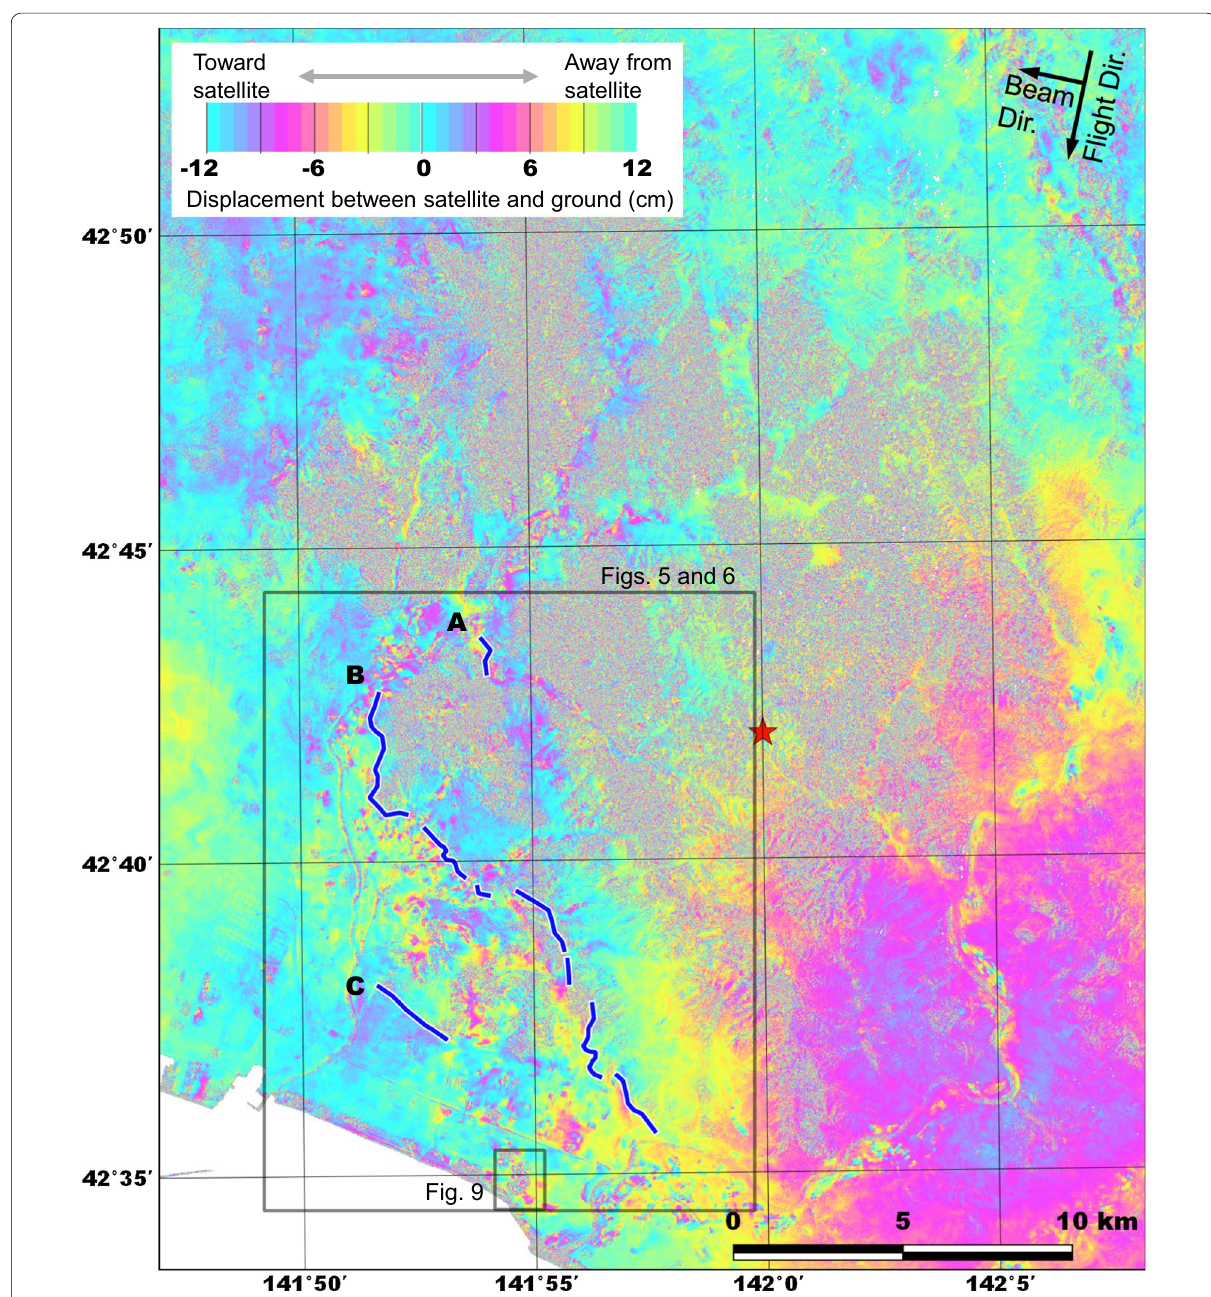
Fig. 2 ALOS-2 SAR interferogram of image pair 3 (Table 1) showing the linear surface displacements identified in this study. The red star shows the epicenter of the 2018 Hokkaido Eastern Iburi Earthquake (Earthquake Research Committee 2018). Rectangles show the area of other figures. Blue lines show the identified linear surface displacements (interferograms without these features are given in Additional file 1: Fig.